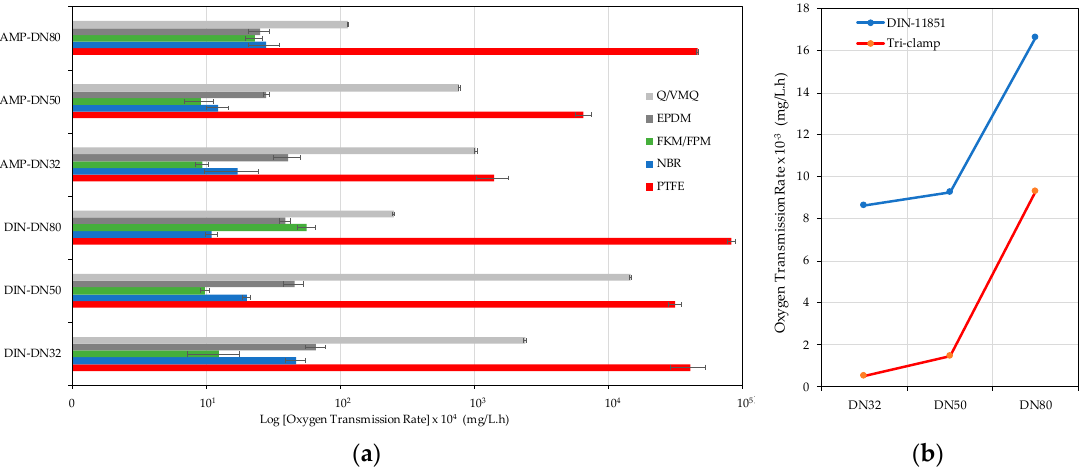
Figure 9. ( a ) Oxygen Transmission Rate (mg/L·h) in the different connectors according to diameter as well as the gasket material referred to the volume of the connector; ( b ) Comparison of mean-corrected OTR with the volume for both connectors according to diameter.